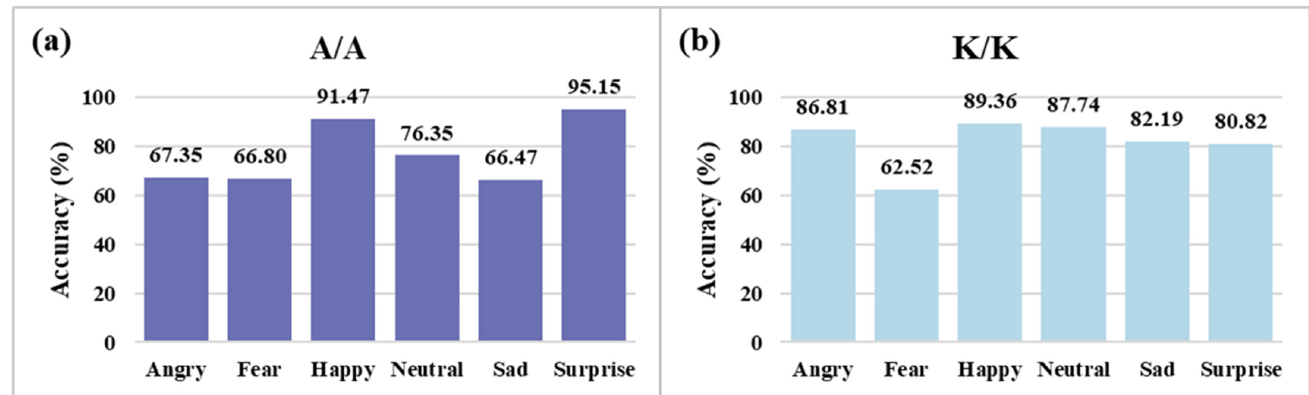
Figure 8. Age-specific accuracy of SE-ResNeXt50 (32 × 4 d) according to different emotions: ( a ) A/A model and ( b ) K/K model.